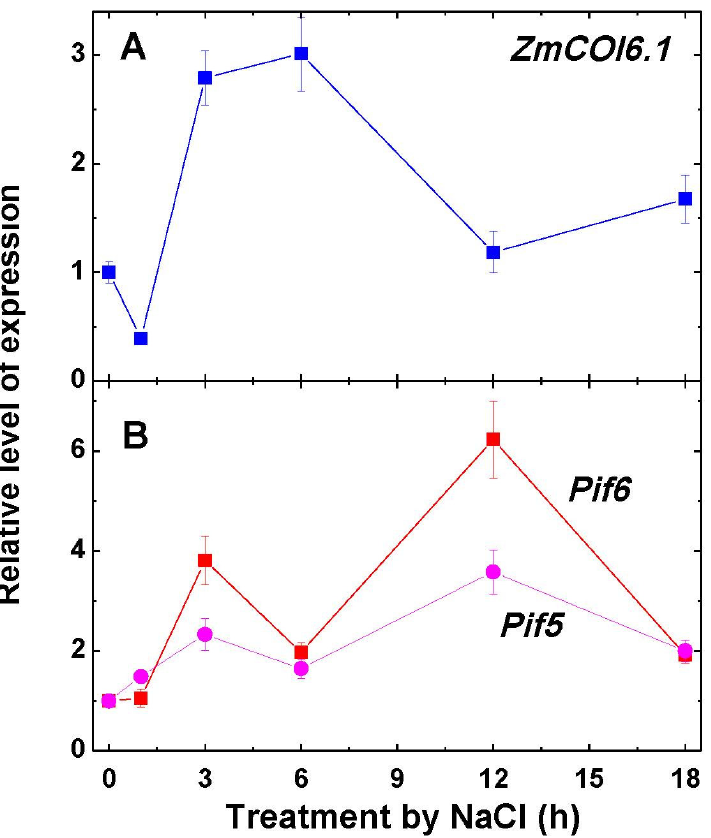
Figure 6. Relative level of transcripts of the gene ZmCOI6.1 ( A ) and of the genes Pif5 and Pif6 ( B ) in maize leaves in the course of incubation of maize seedlings in 150-mM NaCl. The data represent the means of three biological repeats ± SD. The control (untreated) samples of gene expression values did not exhibit statistically significant changes in the variation level.